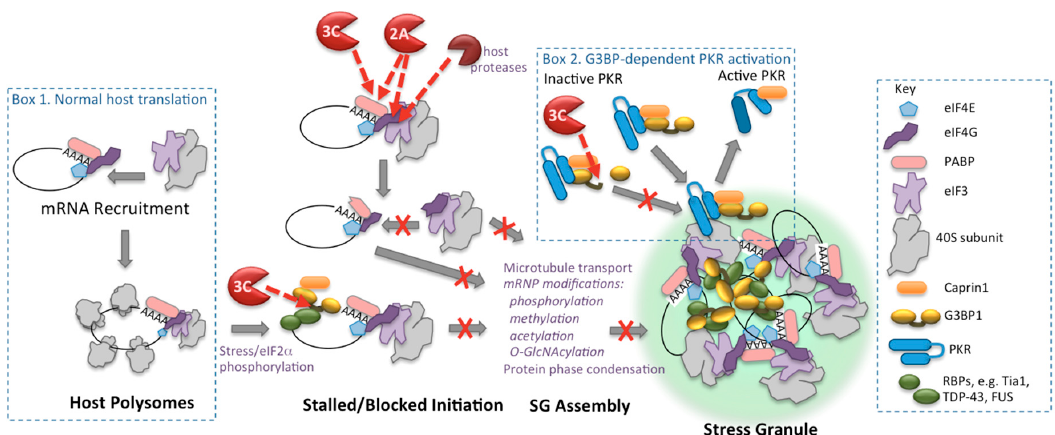
(Figure 1). The viral and cellular proteinases that cleave eIF4G separate the binding domain of eIF4G that interacts with the cap-binding protein eIF4E from the domain that binds eIF3, effectively preventing capped mRNAs from binding ribosomes de novo [7] (Figure 1).